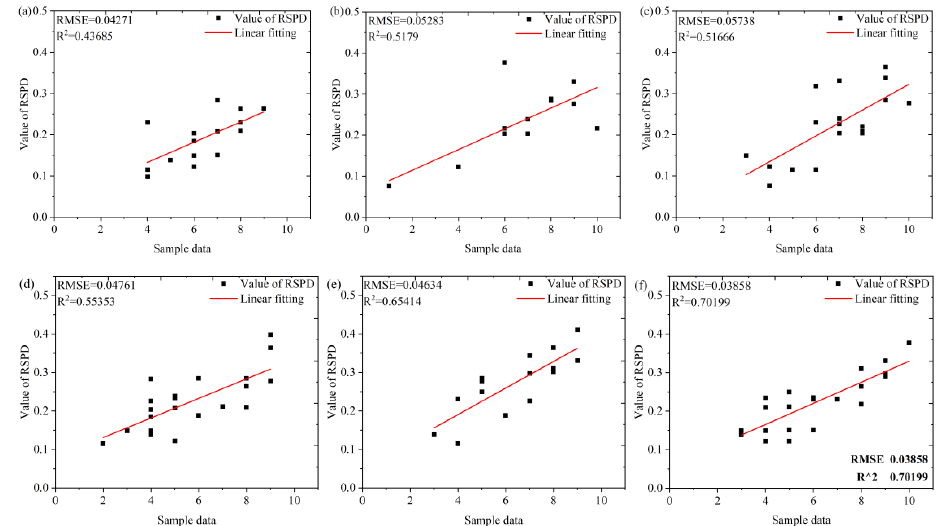
Figure 10. The correlation between the RSPD and the plant diversity grade of sample sites where ( a – c ) are the results of Case I in 2016, 2018, and 2019, respectively; ( d – f ) are the results of Case II in 2016, 2018, and 2019, respectively.